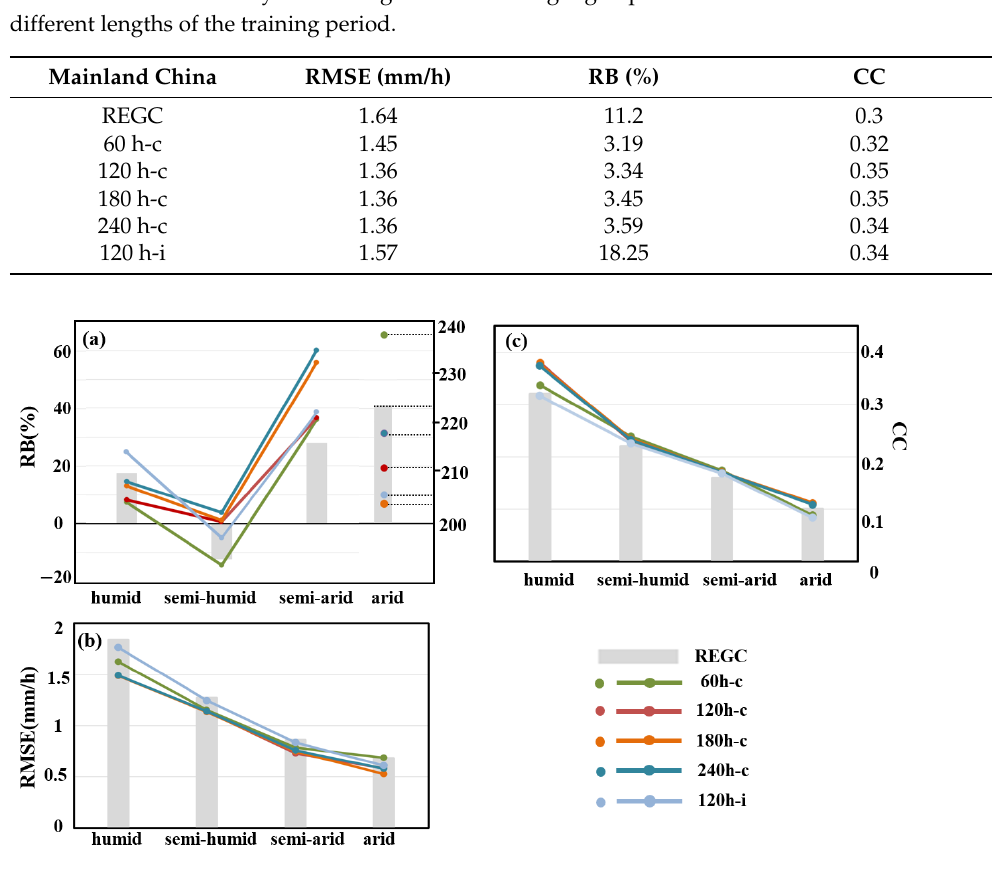
Figure 12. The RB ( a ), RMSE ( b ), and CC ( c ) of hourly SISP-RT against CMPA at gauged pixels compared with REGC in climate regions under the di ff erent lengths of the training period. compared with REGC in climate regions under the different lengths of the training